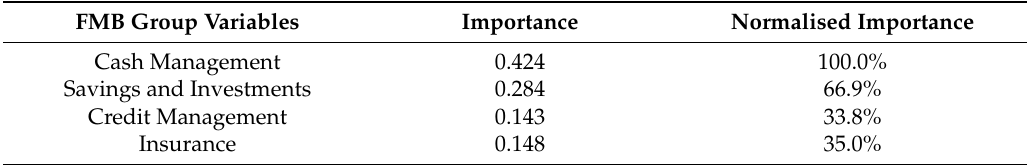
Table 5. Independent variable importance for Model B (calculated by the